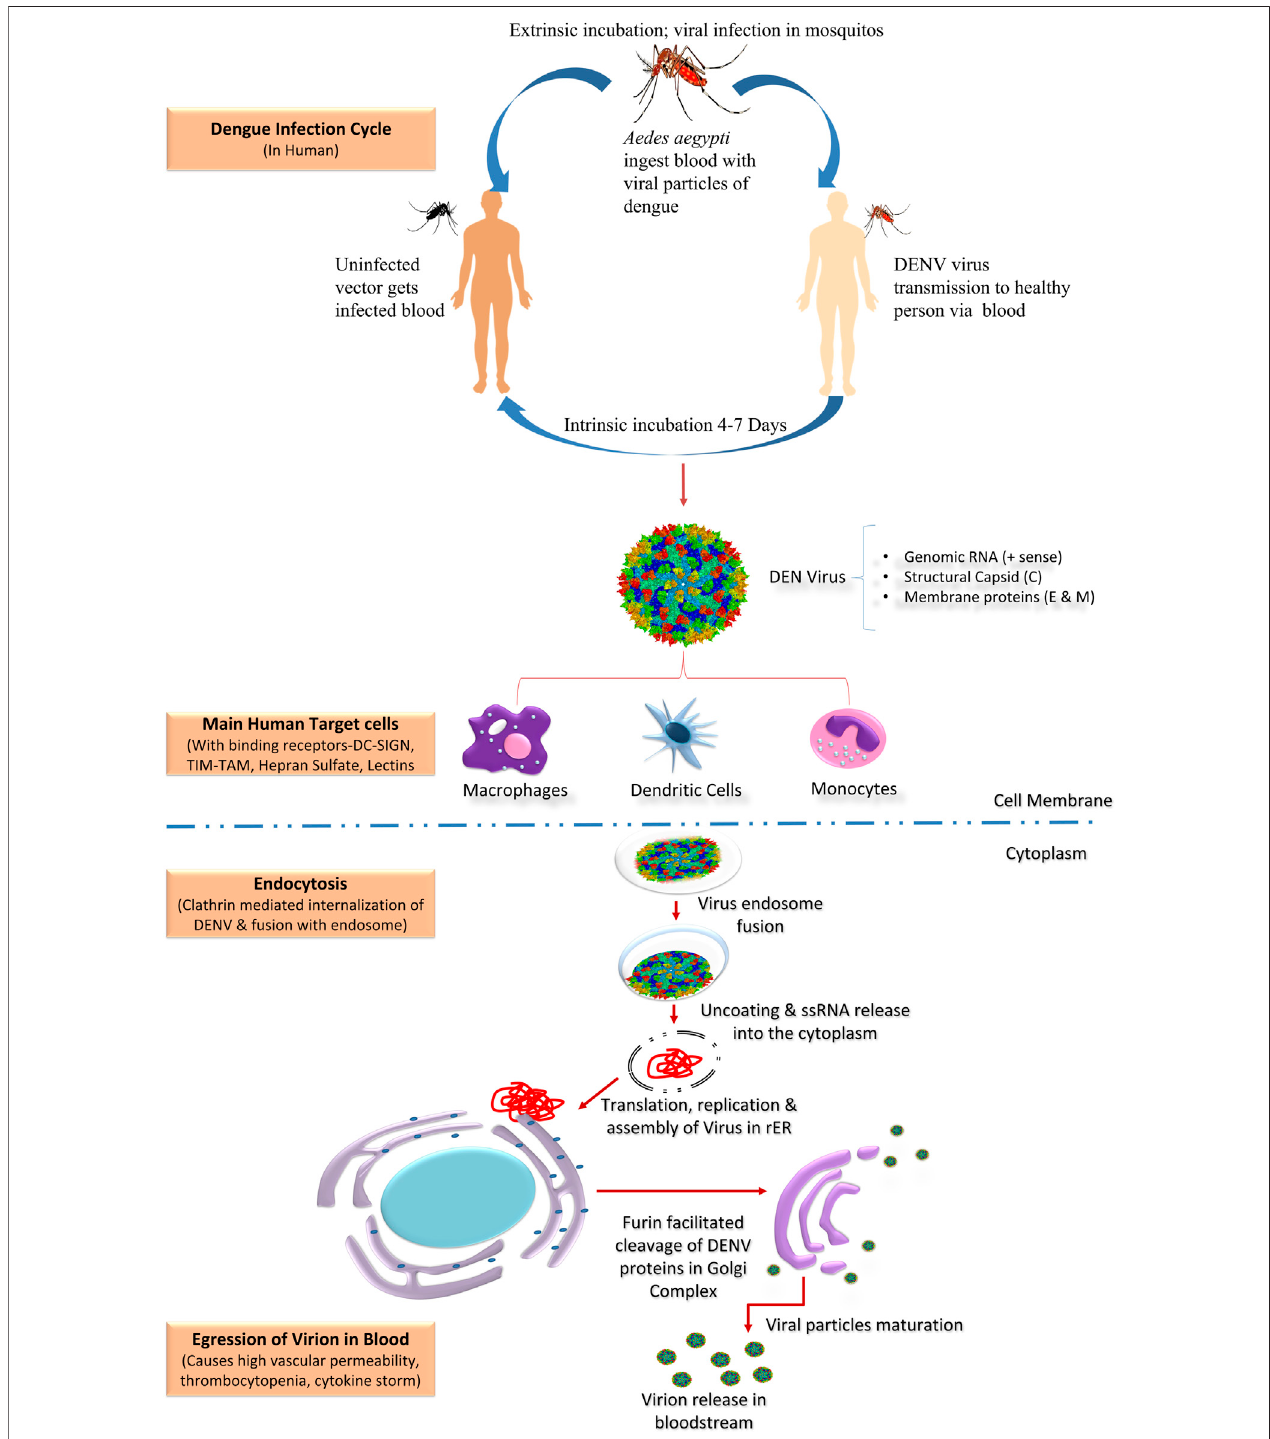
FIGURE 1 | Dengue infection cycle in human